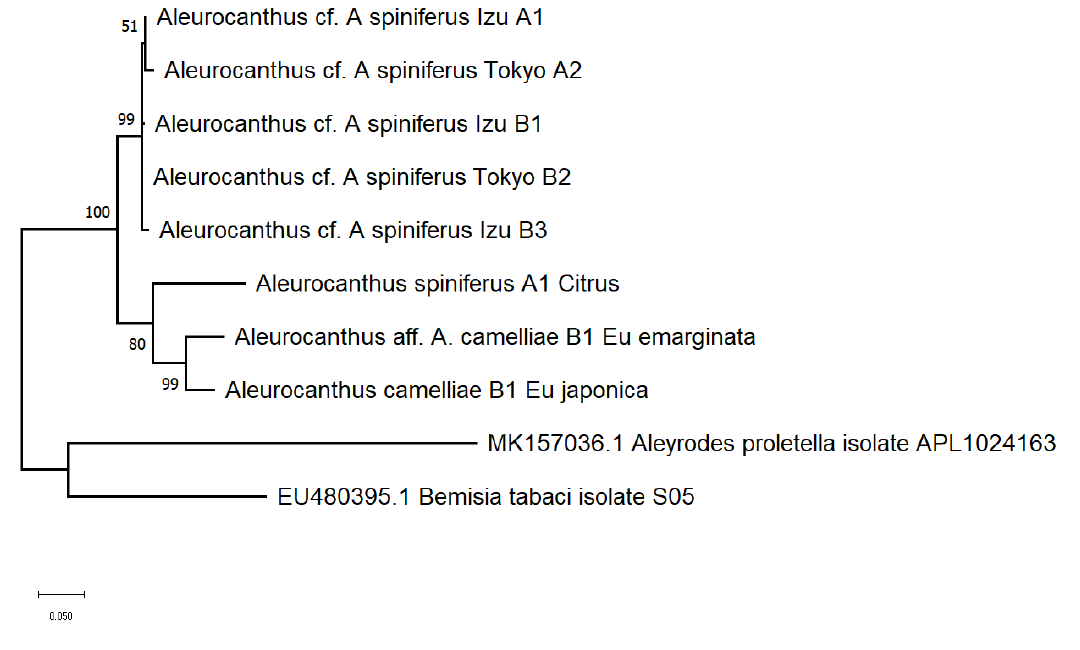
Figure 3. The ML phylogenetic tree of A. camelliae species complex is based on the ITS1 gene constructed using the Tamura and Nei model [65]. The whiteflies Aleyrodes proletella (MK157036.1) and Bemisia tabaci (EU480395.1) were assigned as out-group.